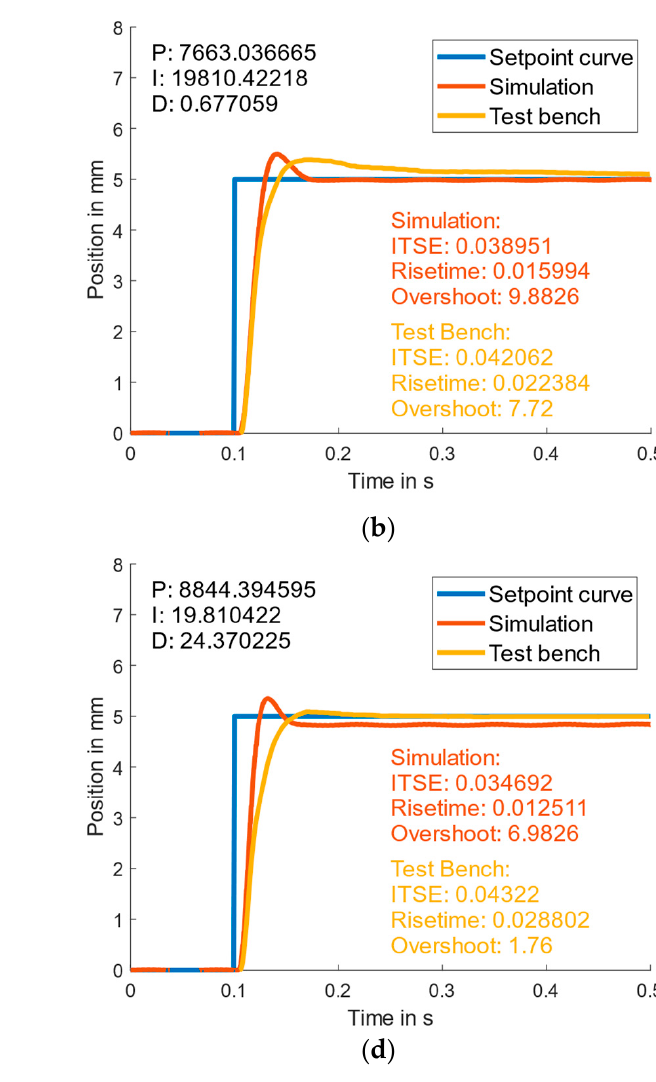
( d ) Figure 7. Comparison of the simulated and on the test bench measured step response of the EHA with the following PID parameters obtained with the method for multi-objective optimization of PID control for the inertial load: ( a ) Ziegler Nichols characterization [ 𝐾 (cid:3017) = 13,800; 𝐾 (cid:3010) = 345; 𝐾 (cid:3010) = 0.0007246], ( b ) system characterization [ 𝐾 (cid:3017) = 7827.556886; 𝐾 (cid:3010) = 806.115288; 𝐾 (cid:3010) = 0.724638], ( c ) first optimization loop [ 𝐾 (cid:3017) = 9441.263070; 𝐾 (cid:3010) = 0.806115; 𝐾 (cid:3010) = 25.386430], and ( d ) second optimization loop [ 𝐾 (cid:3017) = 6167.990306; 𝐾 (cid:3010) = 495.702891; 𝐾 (cid:3010) = 0.025386]. The validation results from Figure 7 are described in the following. For Ziegler and Nichols, the step response shows approximately similar behavior with a significant devi- ation in overshoot and a deviation in rise time. For the system characterization, there are also deviations: While the slope is similar at the start, a sudden change of the gradient can